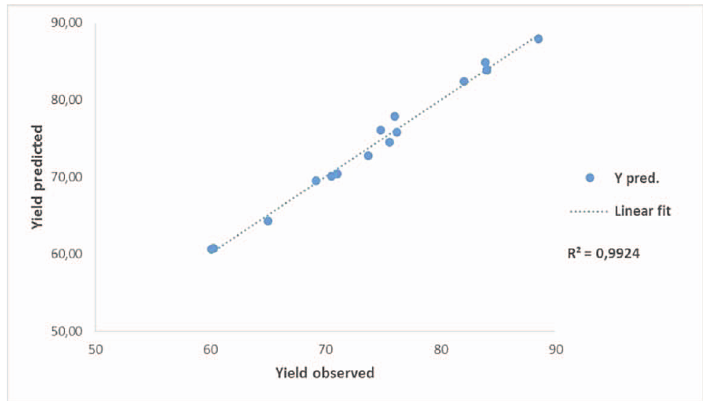
Fig. 2. Yield predicted versus